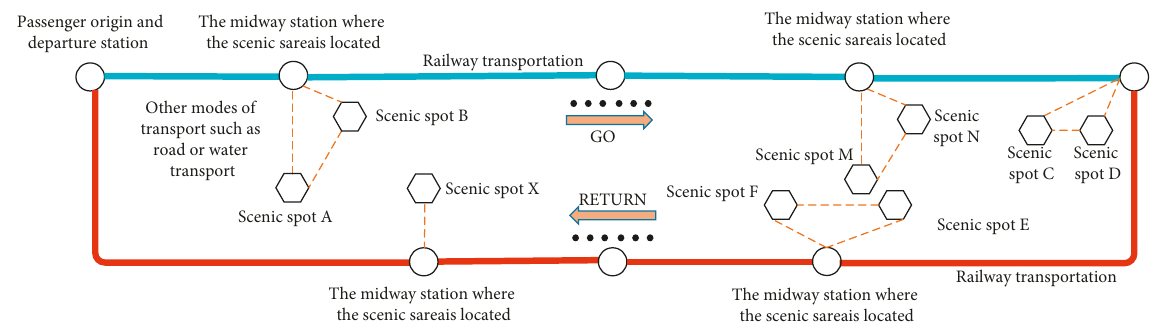
Figure 1: Chart of tour line of tourist-dedicated